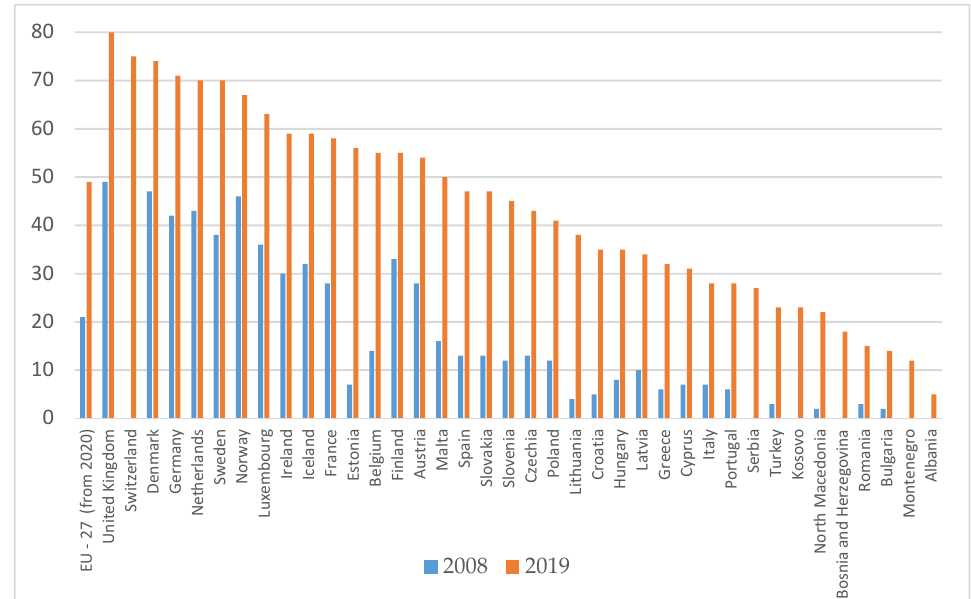
Figure 9. Individuals having ordered/bought goods or services for private use over the internet in the last three months, in 2008 and 2019—percentage of individuals. Source: Authors projection using EUROSTAT database, Digital economy and society (t_isoc_i). Data extracted on 12 September 2021, online data code: TIN00067.